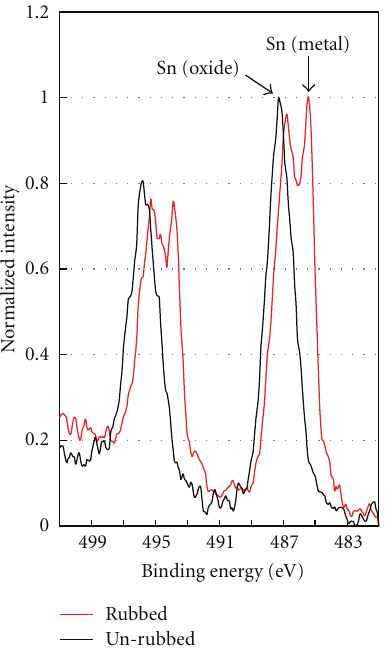
Figure 12: XPS spectrum of rubbed surface: Sn 3d (GMO in PAO for 120 min).